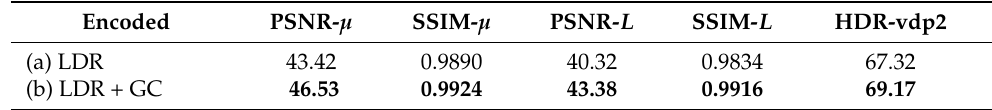
Table 4. Comparison between our approach for encoding both LDR images and their gamma correction (GC) images and a baseline approach that only encodes the LDR